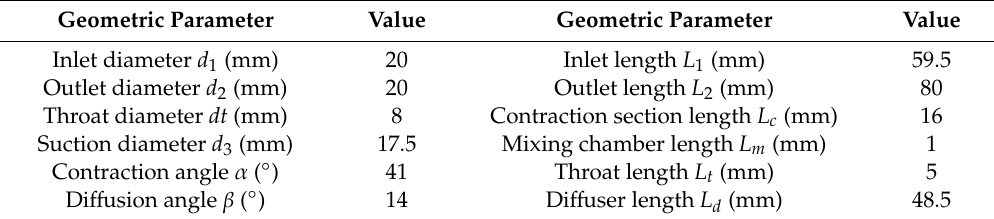
Figure 2. Configuration of the venturi injector. Table 1. Basic geometric parameters of the venturi injector.